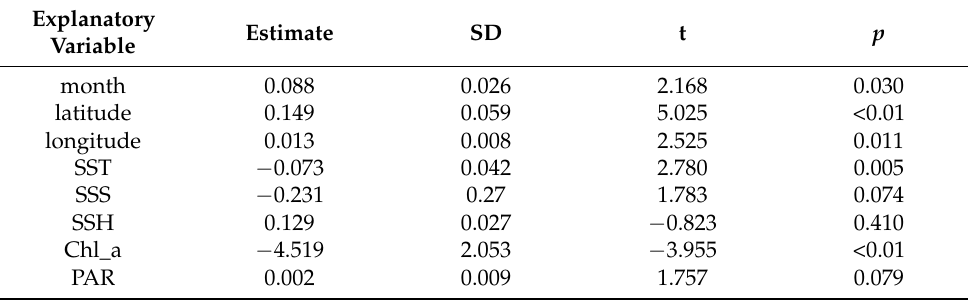
Table 1. The significance test of explained variables in generalized linear models (GLM).